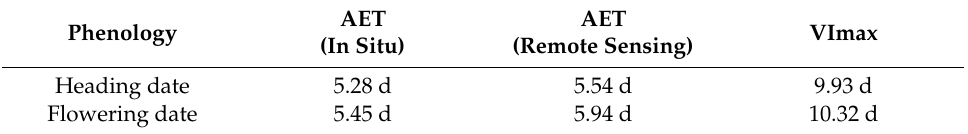
Table A2. The 3-year averaged RMSE for estimated phenology based on AET (in situ), AET (remote sensing), and VI